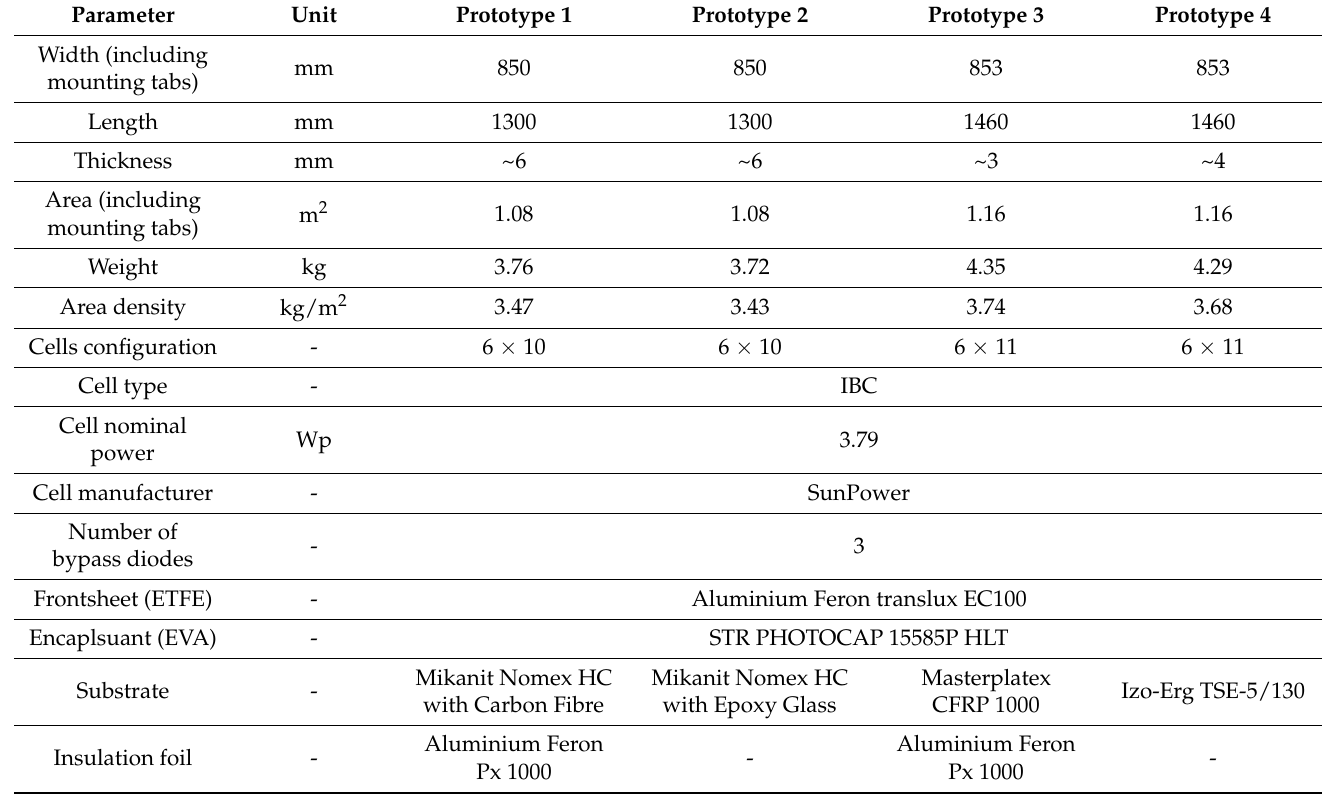
Table 1. Prototypes basic